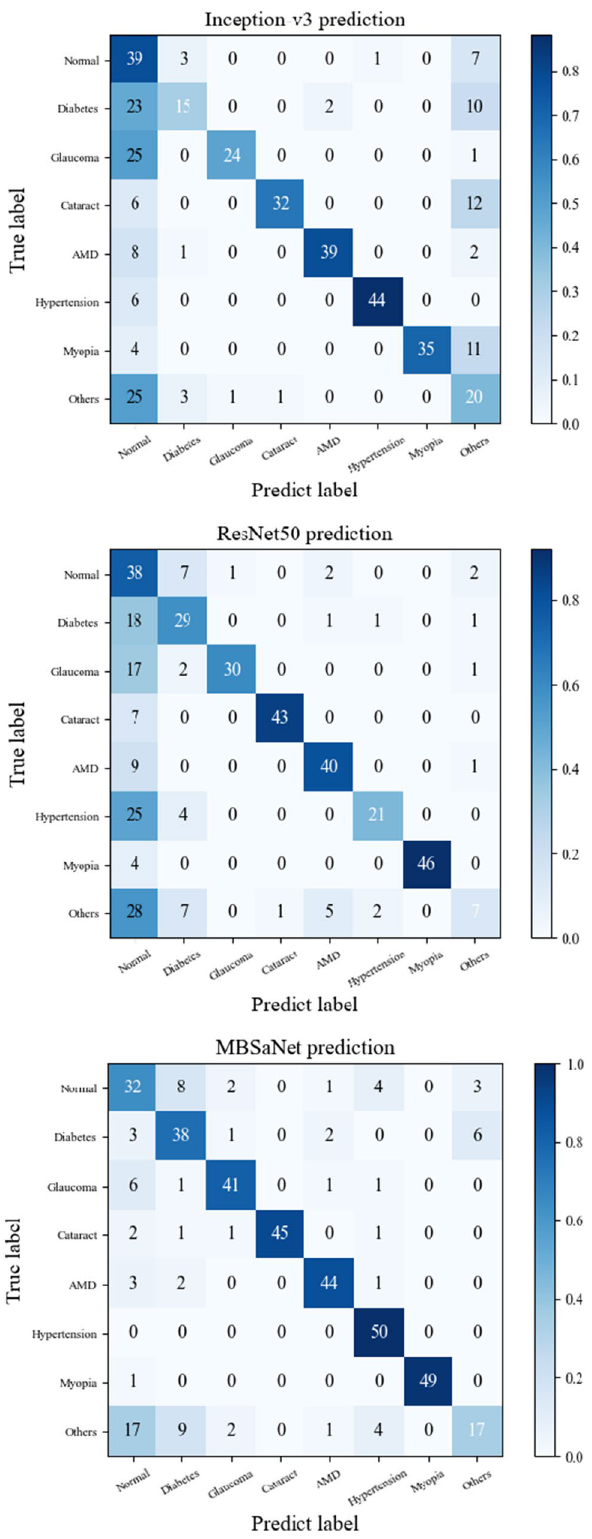
Figure 1. Classification results on the balanced test